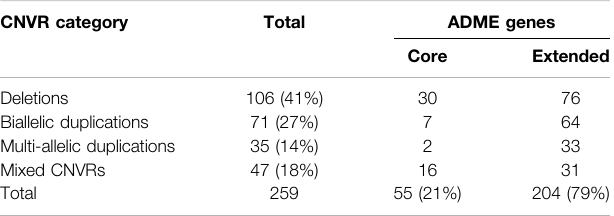
TABLE 3 | CNVRs identi fi ed in core and extended ADME genes (percentages rounded to closest